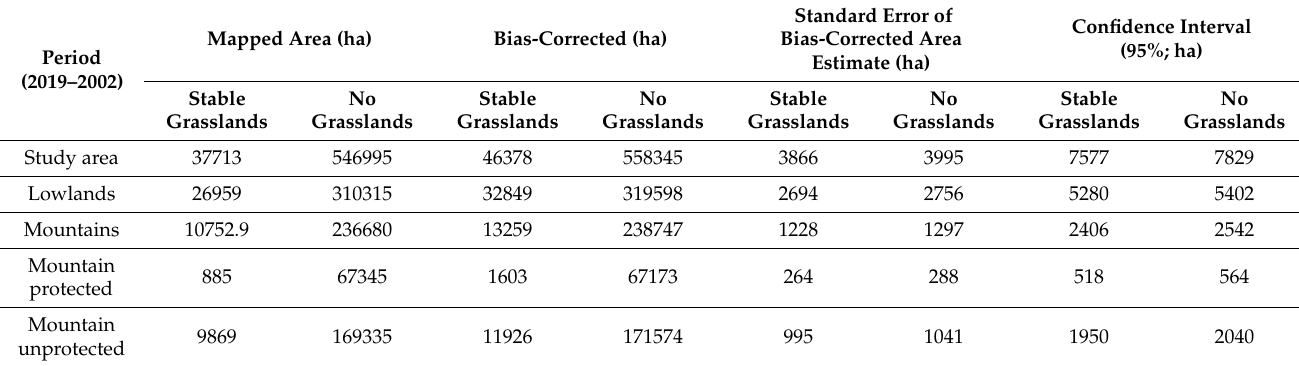
Table 2. Total estimated bias-corrected areas for the stable grasslands and no grasslands classes with margin of error at the 95% confidence level (ha) at all extents of analysis: study area, lowlands and mountain domains, protected and unprotected mountain governance extents. The standard error and the 95% bias-corrected areas (ha) were derived from the error matrix according to the good practices protocol of Olofsson et al. [22].